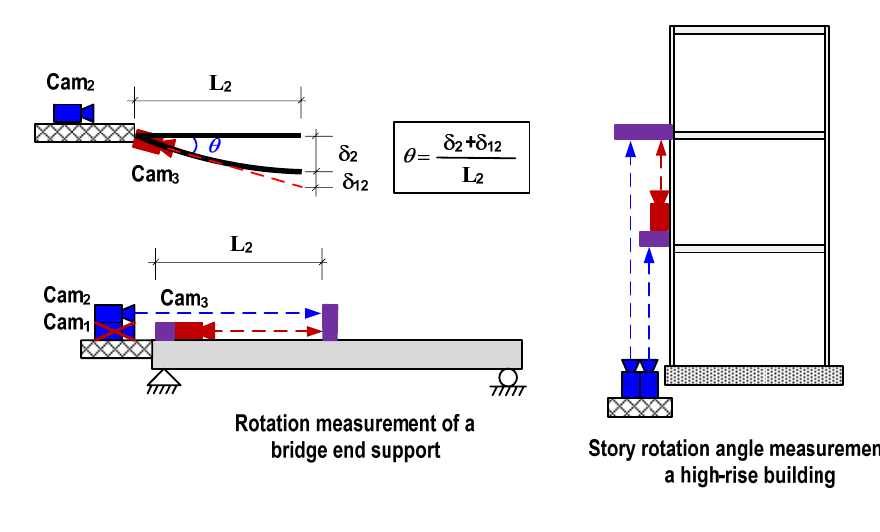
Figure 2. Typical application